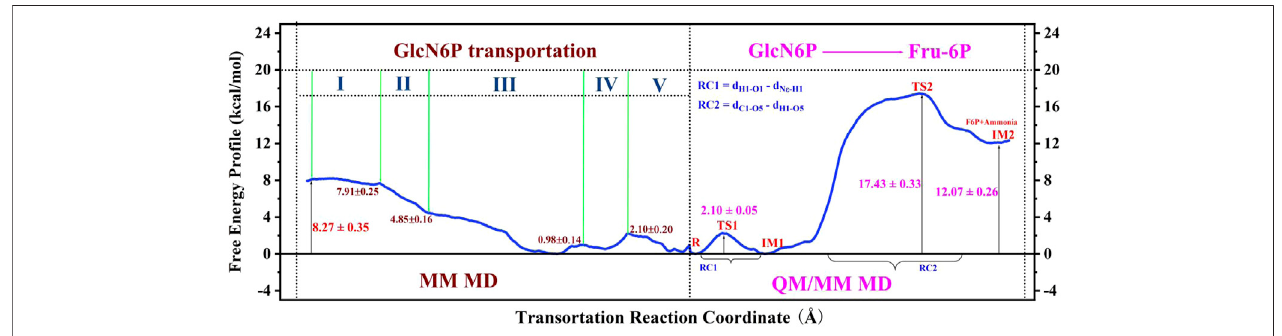
FIGURE 11 | Entire free-energy pro fi le for GlcN6P transportation, and protonation, according to MM MD and QM/MM MD simulations.